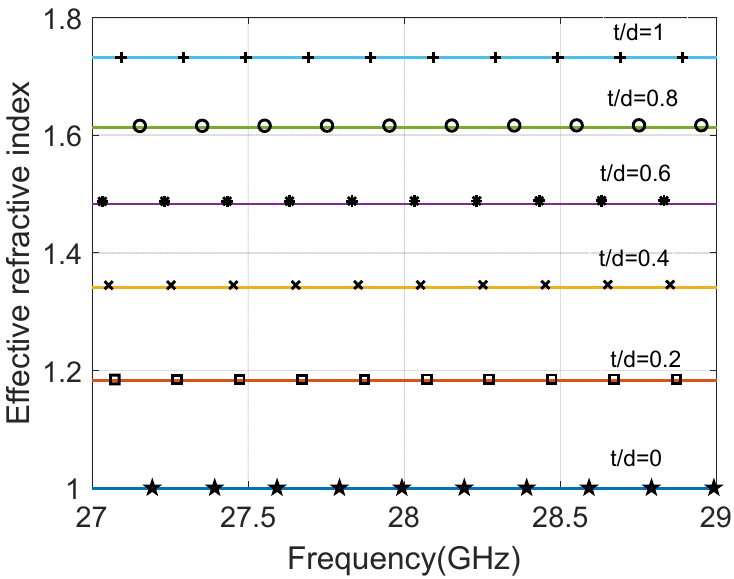
Figure 2. The effective refractive index of the investigated slab with different t / d ratios, 0, 0.2, 0.4, 0.6, 0.8,1, using a full ‐ wave simulator (solid lines) and an analytical calculation (markers).